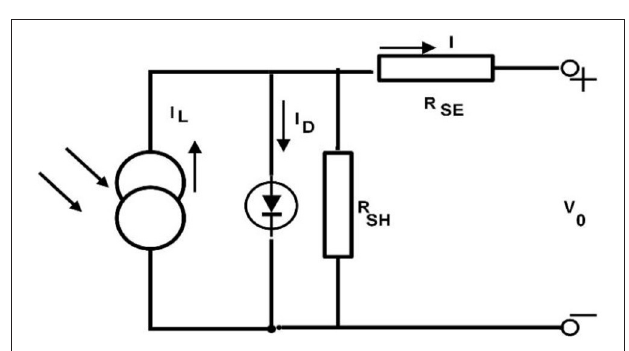
FIGURE 2 | Equivalent circuit model: one-diode photovoltaic (PV) model